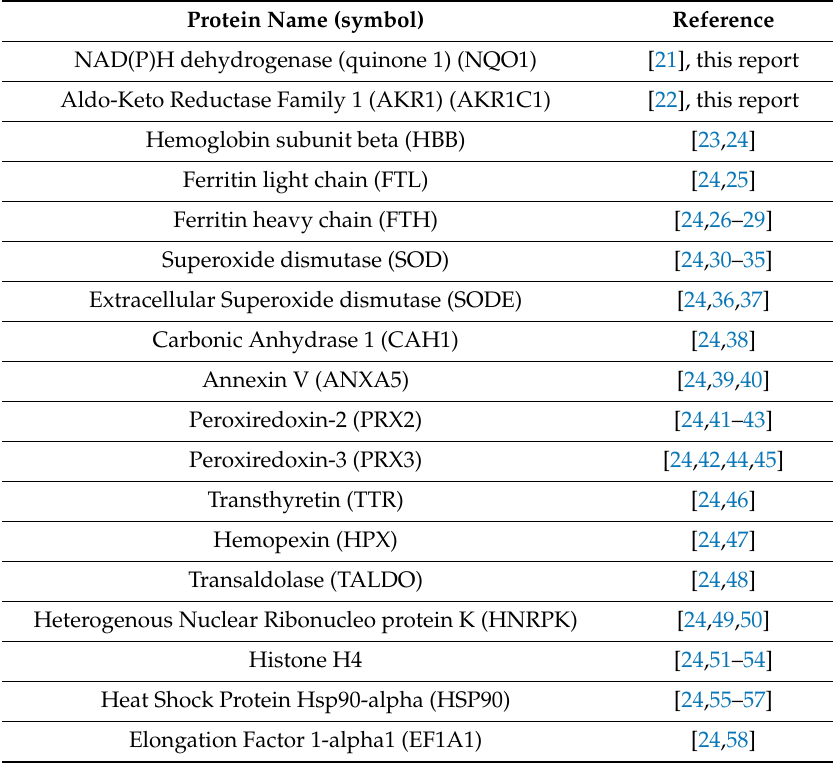
Table 5. NRF2-interacting proteins identified in lung